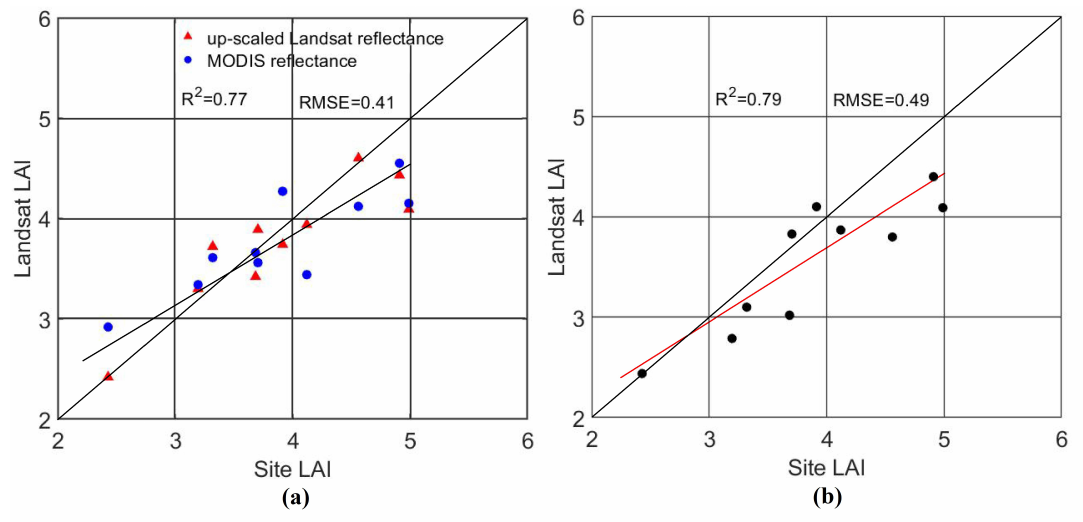
Figure 7. Comparison of inversion LAI with field measurements at the Baoding study area; ( a ) the results of datasets A1 and A2; ( b ) the results of dataset